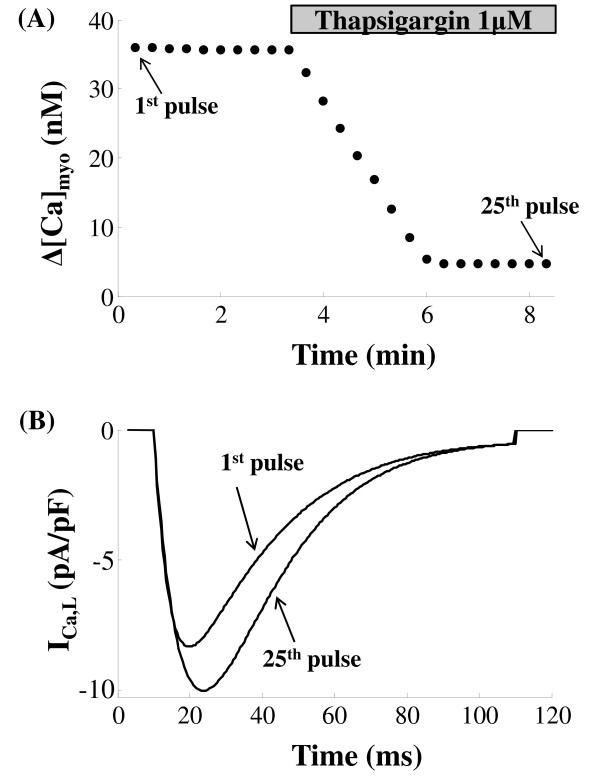
Effects of the application of Thapsigargin. Figure 18: In rat ventricular myocytes dialyzed with 2 mM Fura-2, thapsigargin gradually abolishes [Ca2+]myo transients and decreases the rate of inactivation of ICa,L. This result is generated by the model, in response to a pulse train of amplitude (-40 mV to 0 mV), duration (0.1 sec) and frequency of 0.05 Hz. (A) Time course of the effect of thapsigargin on Δ[Ca2+]i. (B) L-type Ca2+ currents at the times indicated in (A). This model-generated result shows similarity to data in Figure 11, Adachi-Akahane et al. [71]